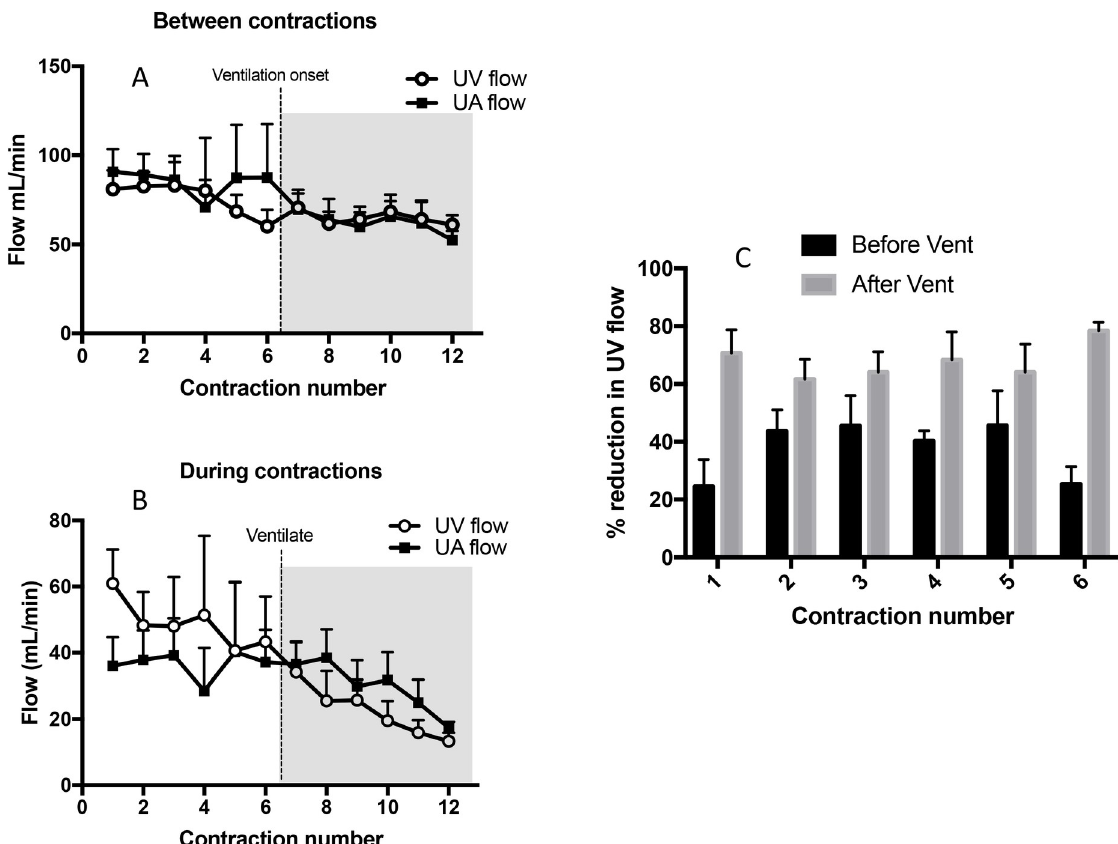
Fig 7. Mean blood flows in the umbilical vein (UV; open circles) and umbilical artery (UA; closed squares) measured immediately before (A) and during (B) consecutive uterine contractions before and after ventilation onset. Both UV and UA flow significantly decreased with increasing contraction number during (p < 0.0001 and p = 0.015, respectively) between (p = 0.0001 and p = 0.001, respectively) contractions (C) The percentage reduction in UV flow during a uterine contraction was significantly greater (p < 0.0001) after ventilation onset (grey bar) compared to before ventilation onset (black